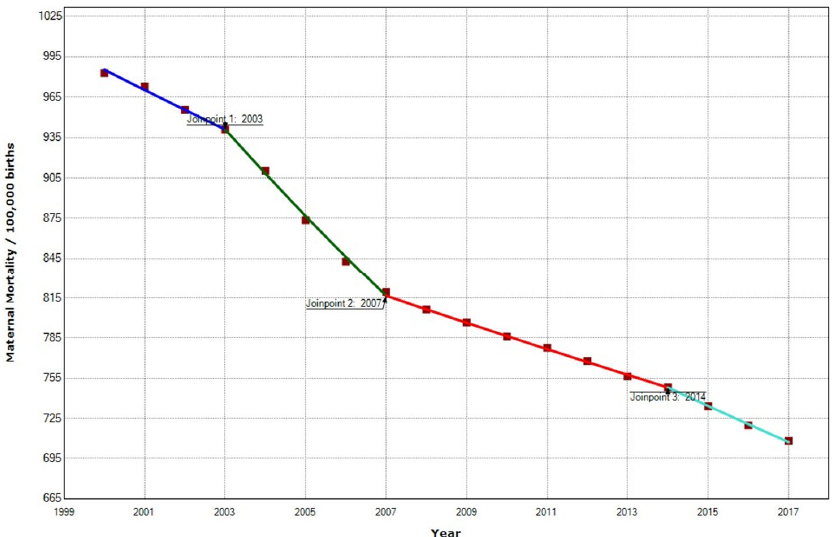
Figure 9. Maternal mortality trends in the West African region (2000–2017) indicate joinpoints at the transitions between colored lines.